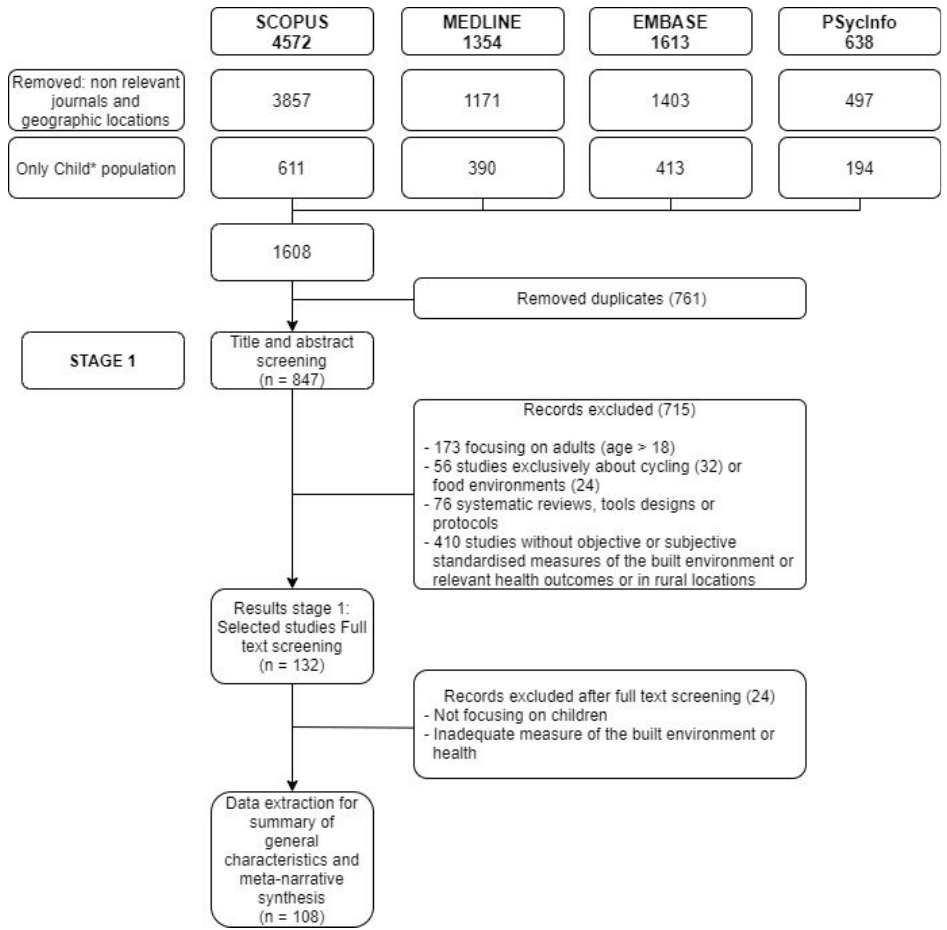
Figure 2. Study flowchart. * was included to capture